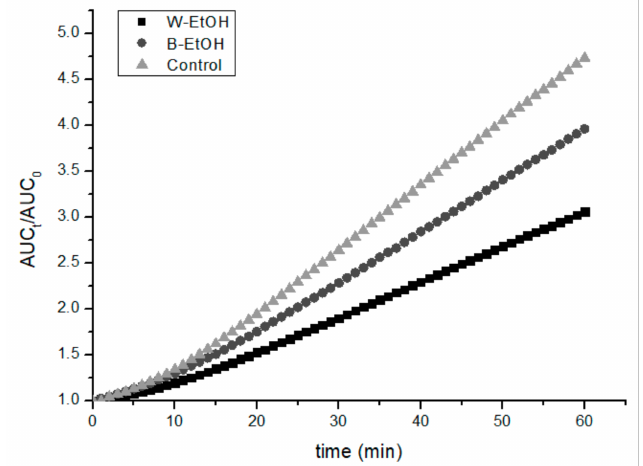
Figure 4. Cellular antioxidant activity of ethanolic extracts in VERO